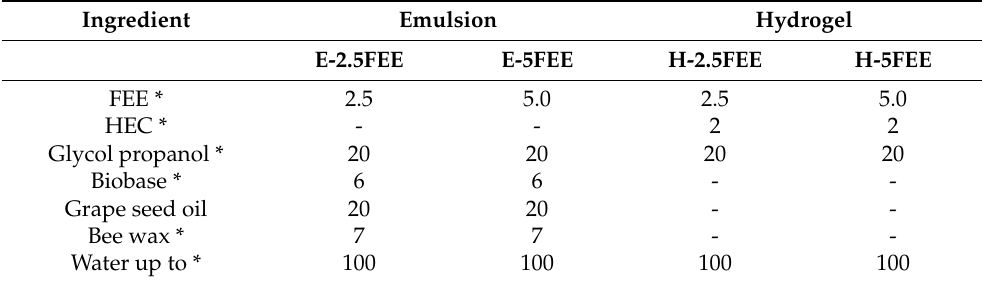
Figure 10. The hydrogel end emulsions with the dry extracts from E. angustifolium FEE. Table 5. Compositions of the prepared hydrogels and emulsions used in the penetration